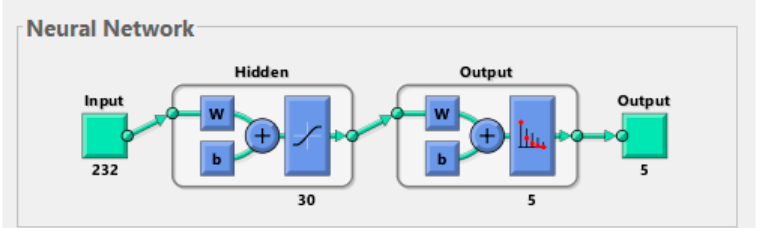
Figure 10. Display performance of the ANN and FFNN algorithms for training a low GI dataset.